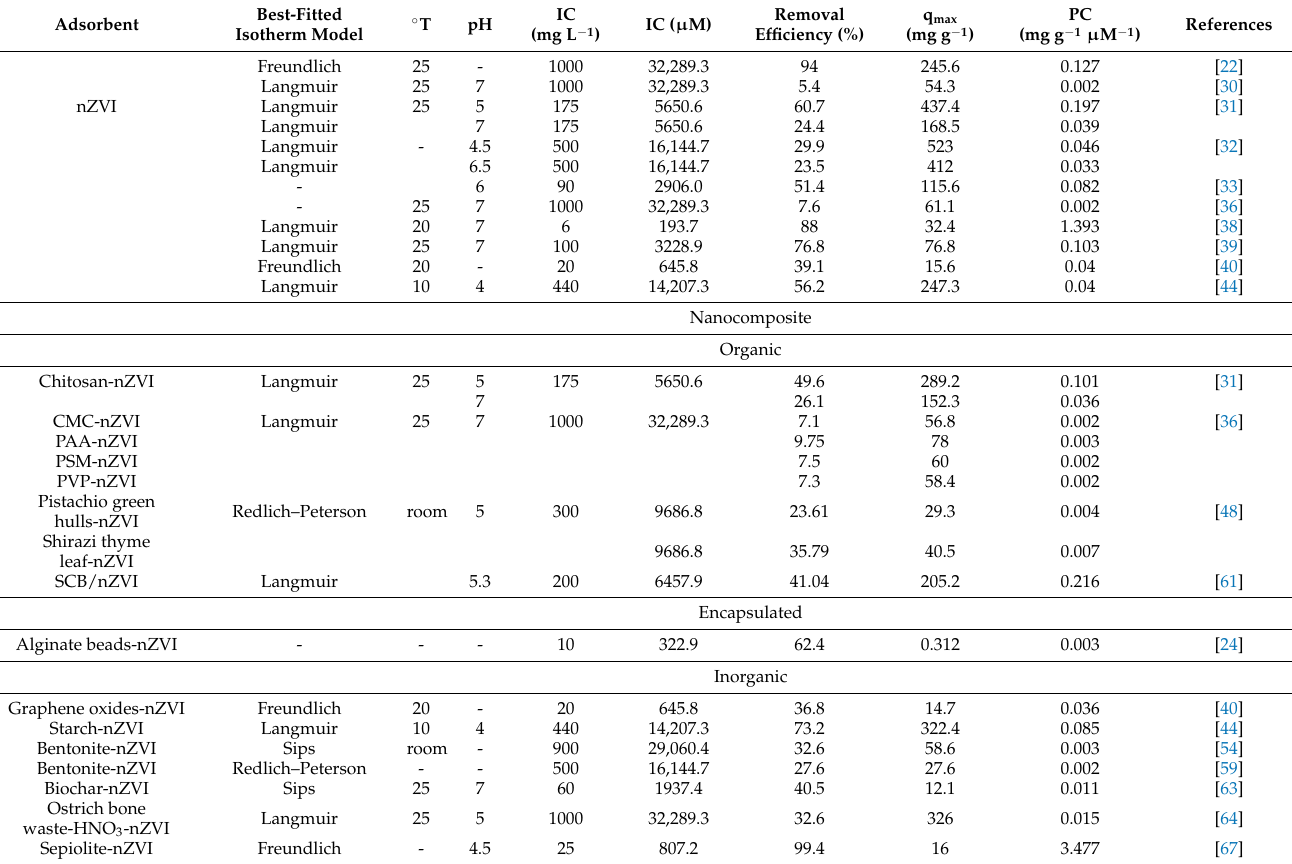
Table 3. Performance of nZVI and its nanocomposites for adsorption of phosphate from aque- ous